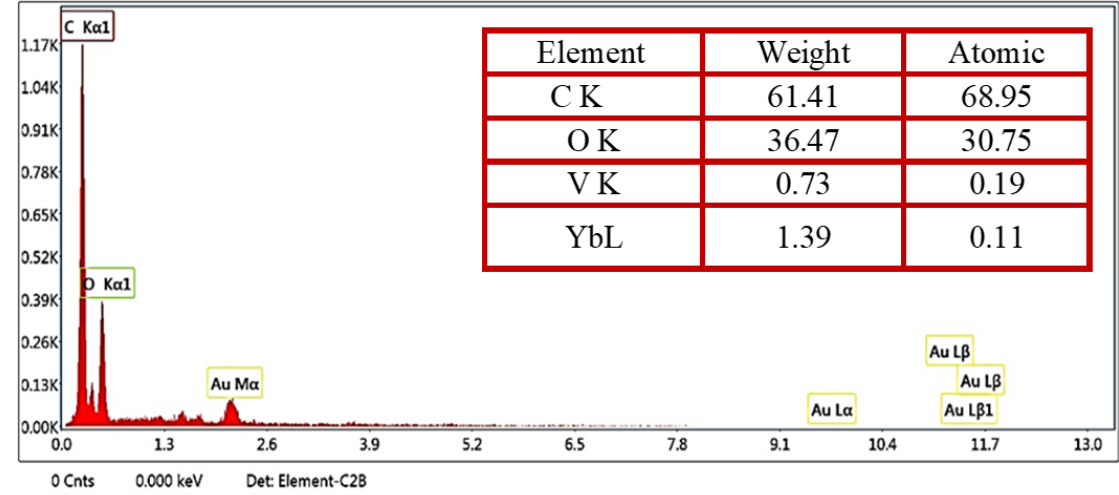
Figure 4. EDX of CS films that contain a different concentrations of Yb 2 O 3 /V 2 O 5 /GO@CS.